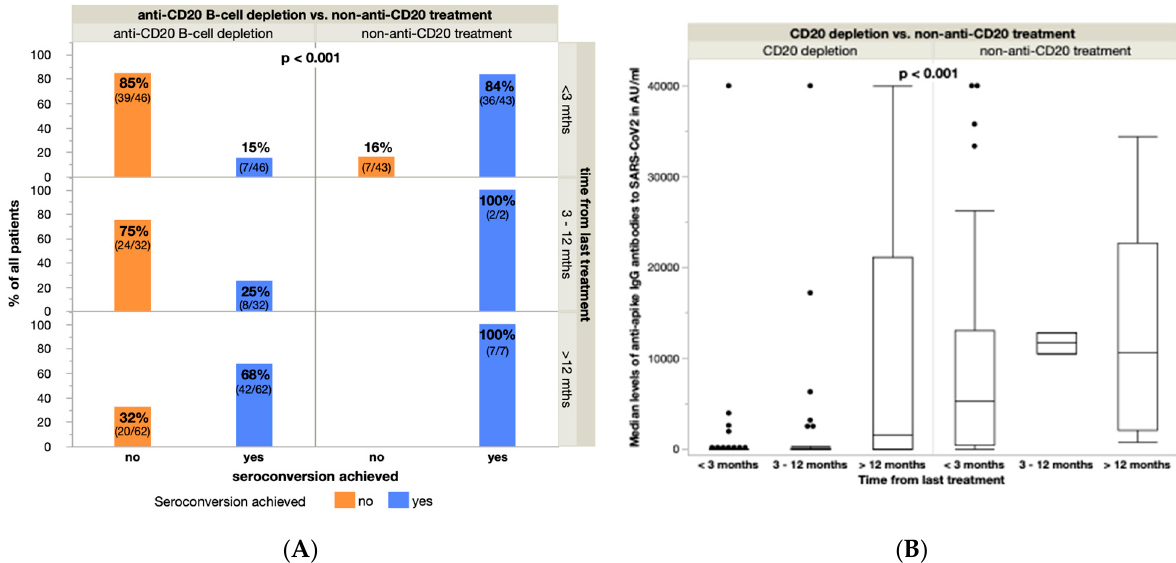
Figure 3. ( A ) Seroconversion rates in relation to the time from last treatment (<3 months, 3–12 months, >12 months) in the anti-CD20 B-cell depletion group vs. the conventionally treated (cytotoxic treatment, targeted treatment, non-anti-CD20 immunotherapy) group. ( B ) Median antibody titer levels in accordance with the time from last treatment compared between the anti-CD20 lymphodepleted group vs. the conventionally treated (cytotoxic treatment, targeted treatment, non-anti-CD20 immunotherapy) group. (Seroconversion rate and median antibody titer levels of patients without treatment prior to prime-boost vaccination (watch and wait-strategy, n = 8) are not